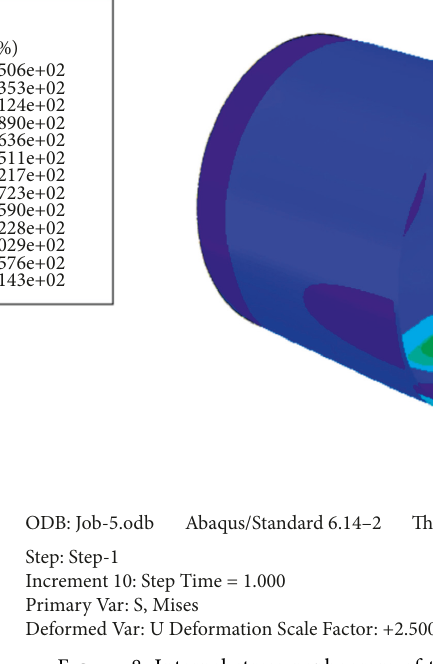
Figure 8: Internal stress nephogram of the defective